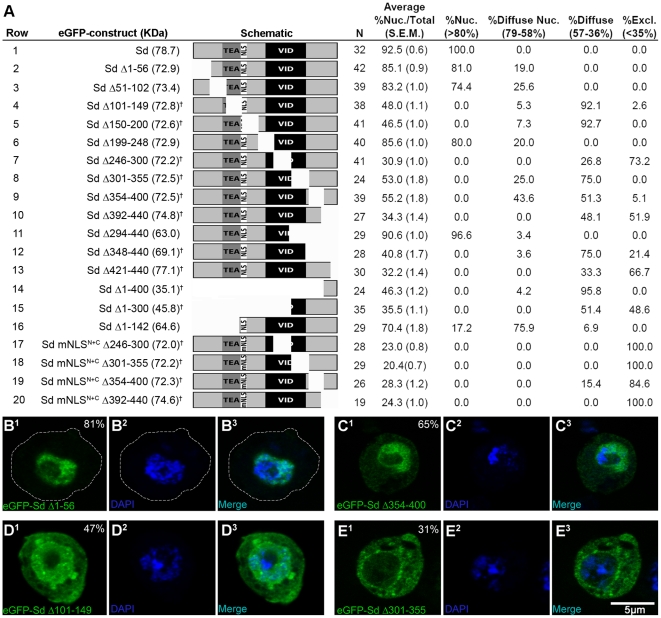
The C-terminal domain can act to both repress and facilitate the nuclear localization of Sd.A series of internal deletions and truncations of Sd were generated, expressed with a fused N-terminal eGFP marker in S2 cells and assayed for cellular distribution. (A) Schematic of the various Sd isoforms generated along with a summary table of the localization experiments. The domains of Sd are as described in Fig. 1A. ‘mNLSN+C’ is described in Fig. 3C. A † denotes a construct with diffuse or nuclear excluded signal (<58% nuclear signal). N is the total number of cells measured from at least two independent transfections. The next four columns represent four arbitrary localization patterns along with the mean nuclear signal each grouping represents. For each peptide, the percentage of cells that fall into one of the four categories is indicated. (B–E) Representative cells showing 81%, 65%, 47% and 31% nuclear signal (B, C, D and E, respectively). See the legend for Figs. 2A–G for details.